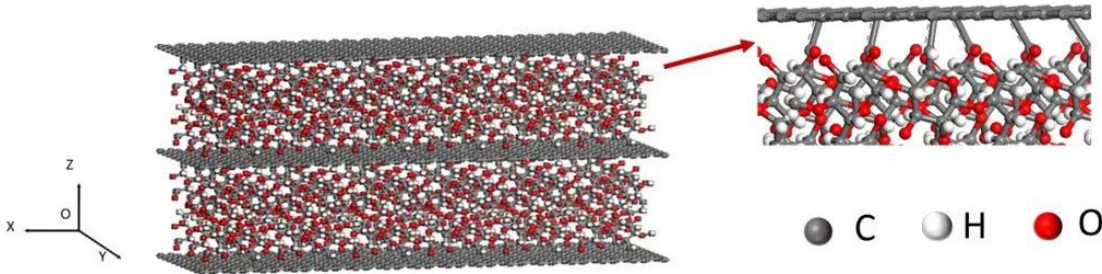
Figure 1. A schematic representation of the MD simulation model of CNCs-graphene layered struc- ture.